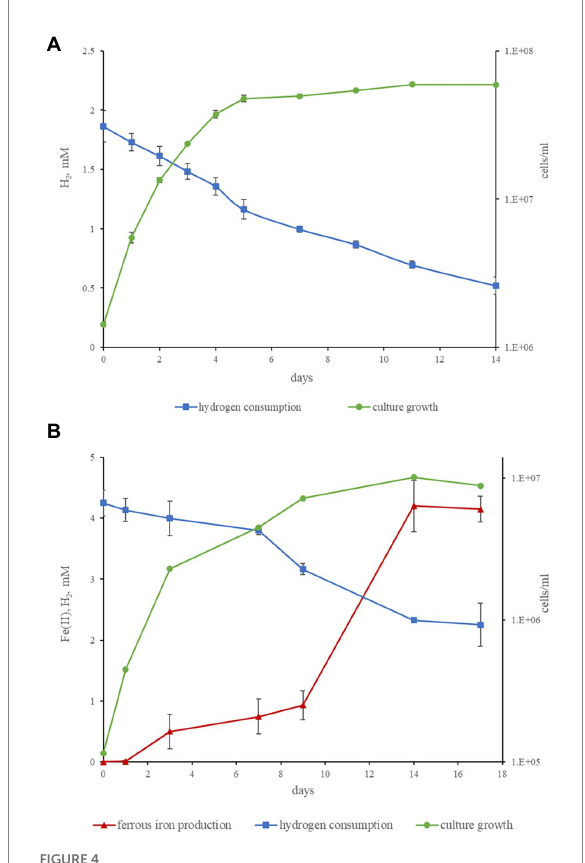
FIGURE 4 Kinetics of hydrogenotrophic growth of strains M08DHB T and Es71-Z0120 T . (A) Growth curve of strain M08DHB T on the medium with hydrogen and thiosulfate in the presence of yeast extract, hydrogen consumption by the strain. (B) Growth curve of strain Es71-Z0120 T on the medium with hydrogen and SF, hydrogen consumption and Fe(III) reduction. Note different cell yields of the strain M08DHB T growing lithoheterotrophically with yeast extract and the strain Es71-Z0120 T growing lithoautotrophically with insoluble electron acceptor